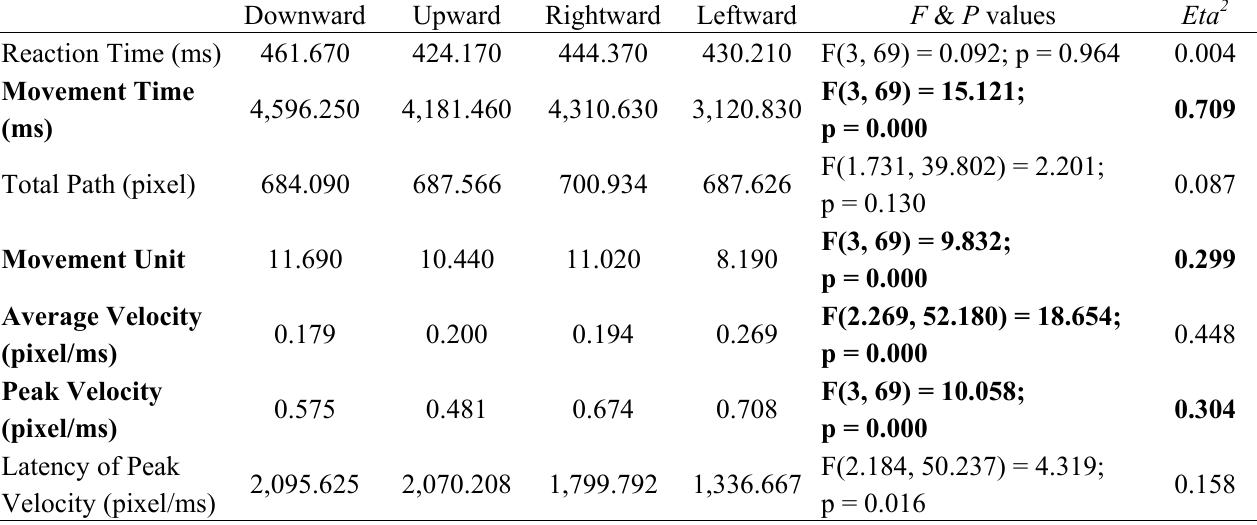
Table 2. The mean values of kinematic variables of each direction and the results of ANOVAs.